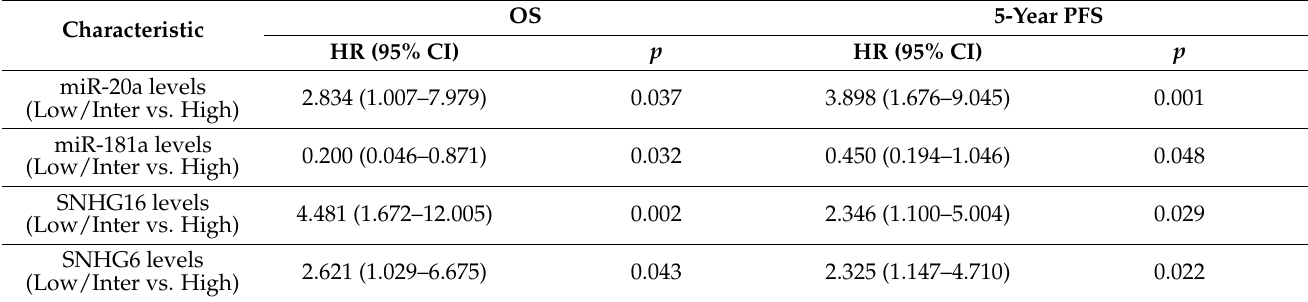
Table 4. The results of the univariate analysis for overall survival and 5-year progression-free survival.